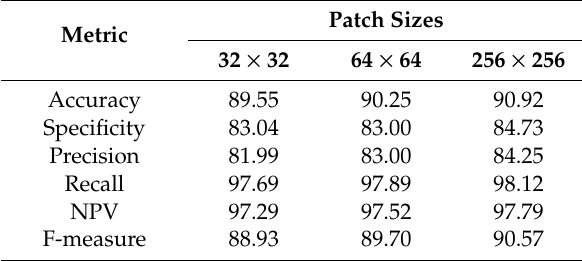
Table 7. Performance of crop segmentation with patches of di ff erent